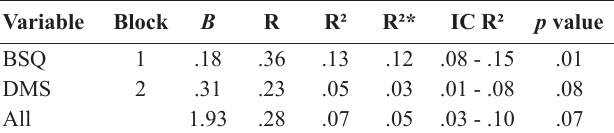
Table 3. Multiple Linear Regression that used the BSQ and DMS on Bulimia and Food Preoccupation Subscale Variance of the EAT-26 in Male Surfers.